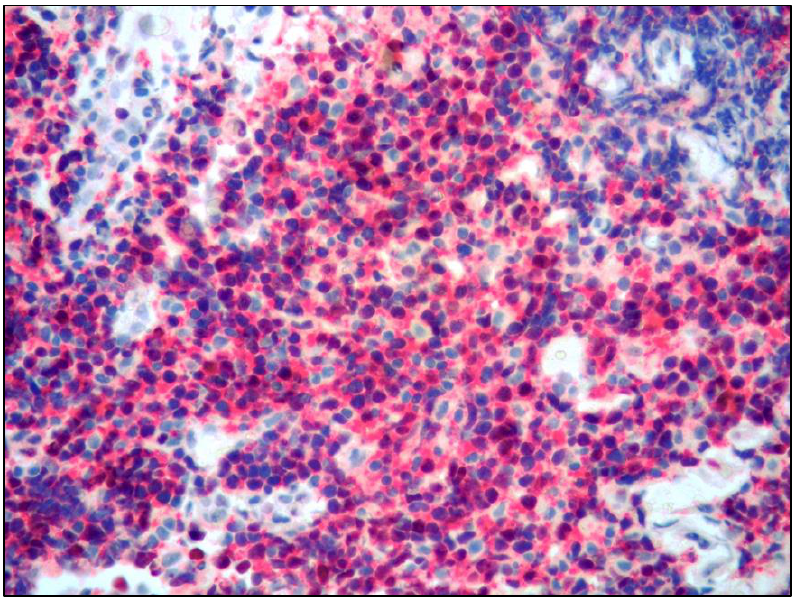
Figure 5. Diffuse cyclin D1 expression of the lymphoid proliferation (cyclin D1 immunostaining; 200× magnification; original image from Prof. S.A.).